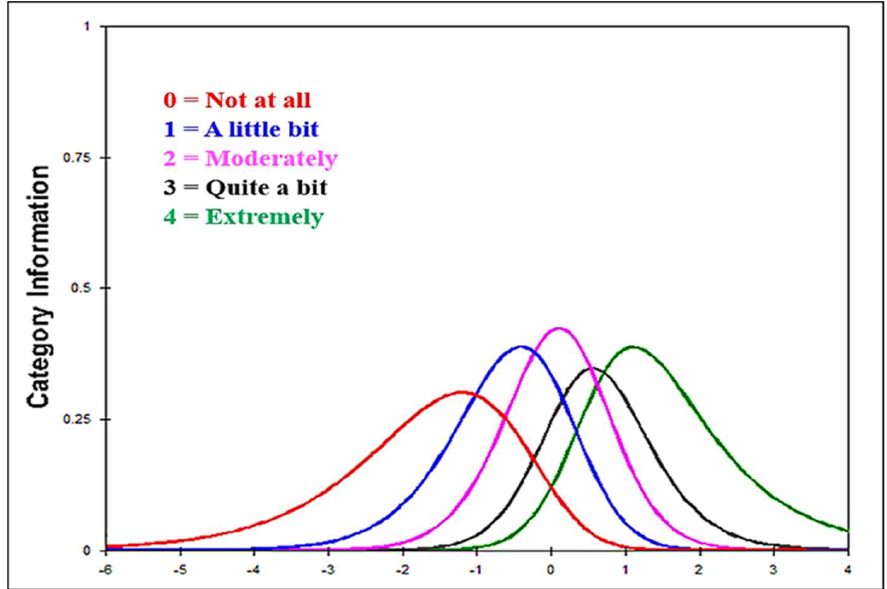
Figure 1. Probability model for the five Likert scales in the Impact of Event Scale-Revised. The point measure of correlation of the 22 items reached the acceptable standard (≥0.30), ranging from 0.44 (Q20_INT) to 0.64 (Q3_INT) (Table 4). The item-reliability of the IES-R was 0.98. The item-separation of the IES-R was 7. Similarly, the person-reliability of the IES-R was 0.88, and the person-separation was 2. Table 4. Rasch parameters of the Impact of Event Scale-Revised (IES-R).